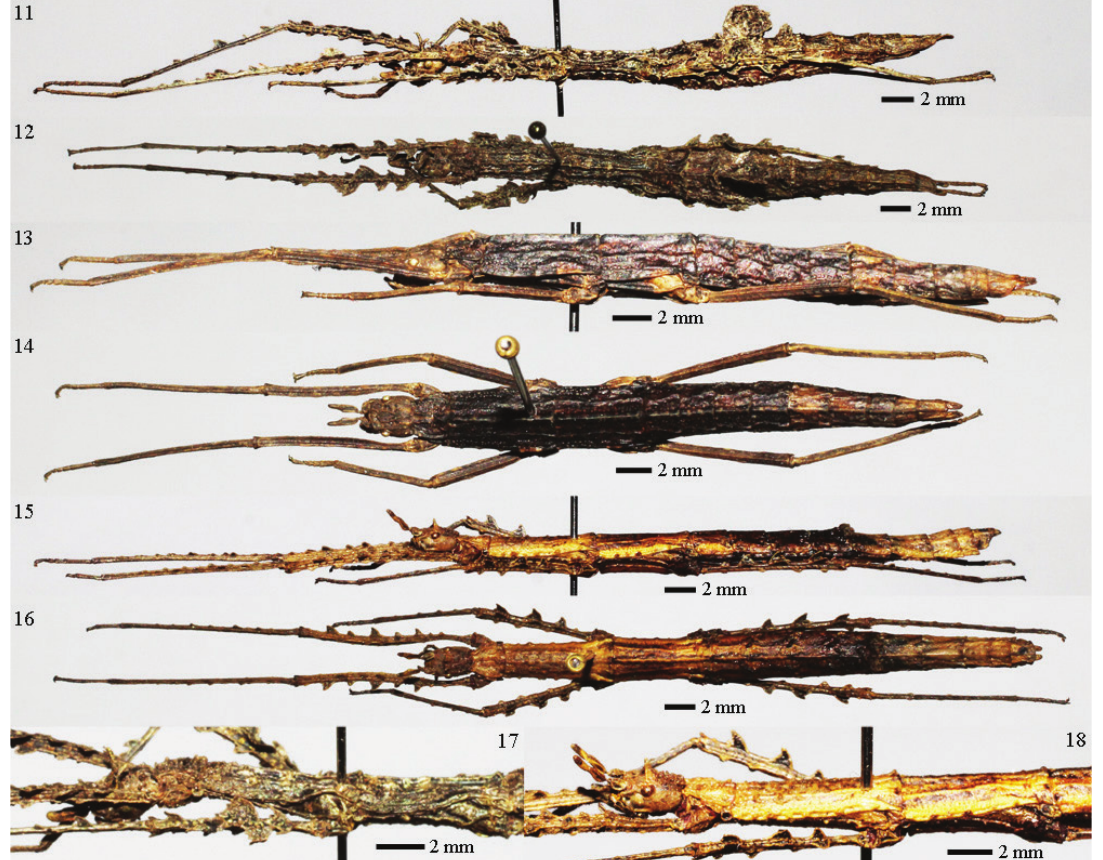
Figs 11–18. Paragongylopus ( Paragongylopus ) s. str. spp. 11. P . ( Paragongylopus ) cheni sp. n.: ♀ , habitus, lateral view; 12. P . ( Paragongylopus ) cheni sp. n.: ♀ , habitus, dorsal view; 13. P . ( Paragongylopus ) plaumanni Zompro, 2000: ♀ , habitus, lateral view; 14. P . ( Paragongylopus ) plaumanni Zompro, 2000: ♀ , habitus, dorsal view; 15. P . ( Paragongylopus ) sinensis pingbianensis subsp. n.: ♀ , habitus, lateral view; 16. P . ( Paragongylopus ) sinensis pingbianensis subsp. n.: ♀ , habitus, dorsal view; 17. P . ( Paragongylopus ) cheni sp. n.: ♀ , head and thorax, dorso- lateral view; 18. P . ( Paragongylopus ) sinensis pingbianensis subsp. n.: ♀ , head and thorax, dorsolateral